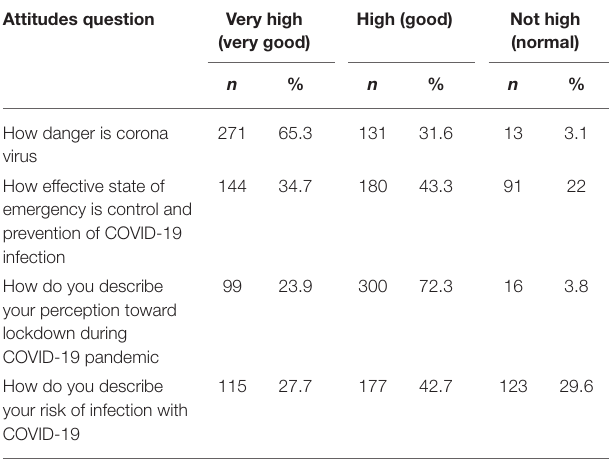
TABLE 2 | Frequency of respondent’s knowledge on coronavirus, Dire Dawa administration, Eastern Ethiopia, May 2020 ( N = 415).